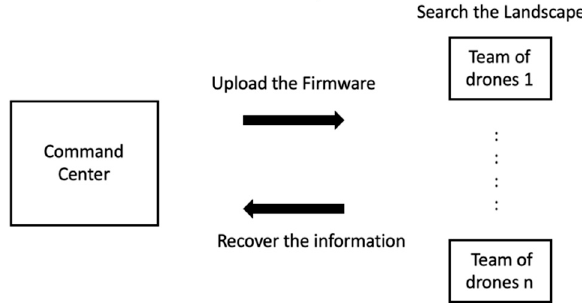
Figure 1. Drone Squadron Optimization (DSO) search cycle.